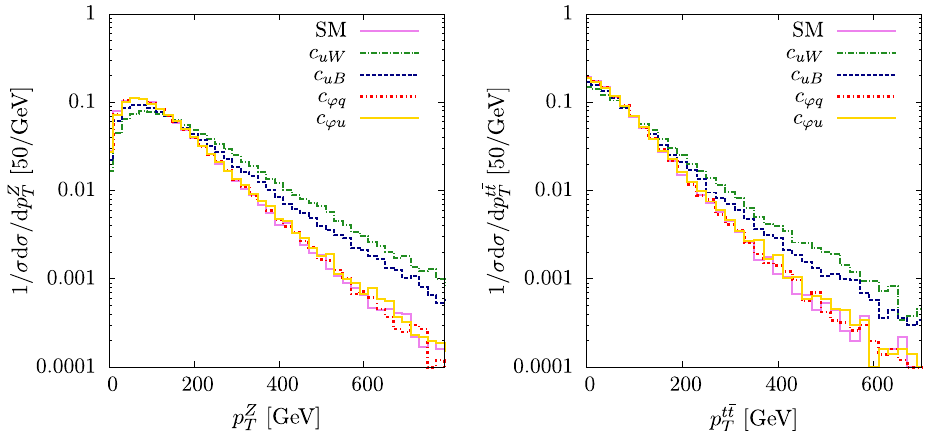
Fig. 3 Kinematic distributions in pp → t ¯ tZ production at 13 TeV for the SM prediction and for the operators of Eq. (II.4) switched on to their maximum value allowed by current data. Left The Z boson transverse momentum spectrum. Right p t ¯ t